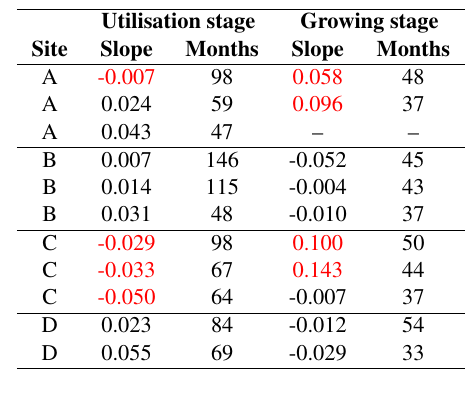
Table 3. Trend assessment results